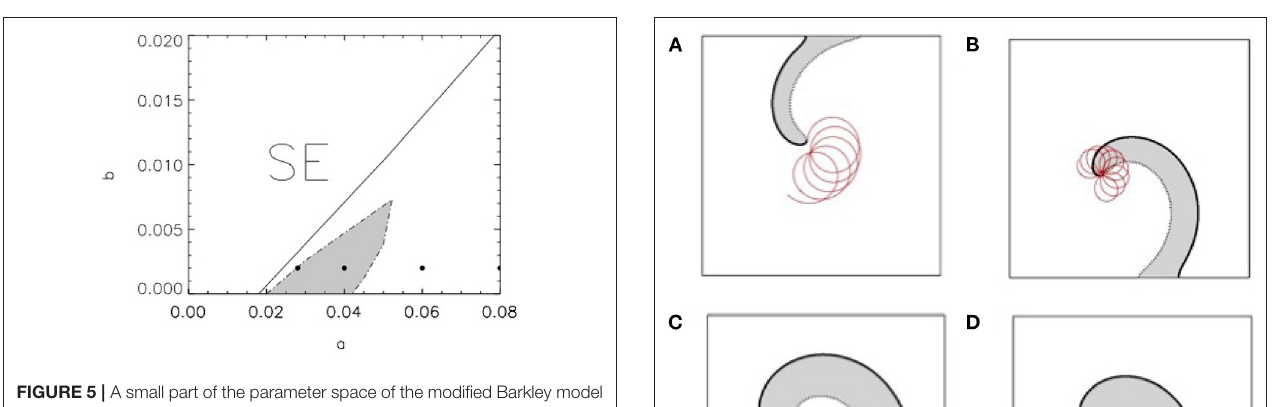
FIGURE 5 | A small part of the parameter space of the modified Barkley model with k ǫ = 20 and ǫ = 0.001. The 2D medium does not support self-sustained spiral waves within the SE domain. Within the gray region spiral waves are unstable. Black spots correspond to parameter values used in Figure 6 .